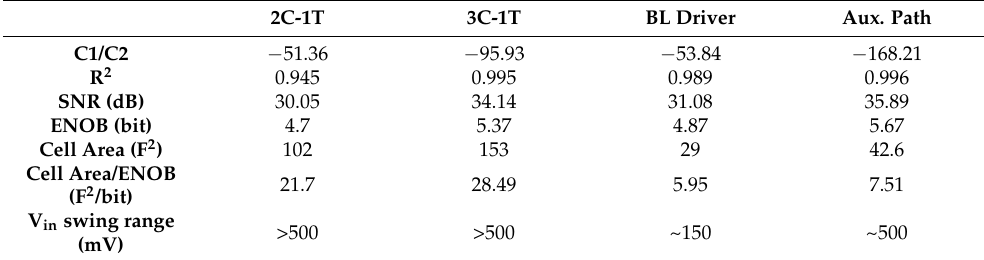
Table 5. Key performance parameters of the charge storage FET